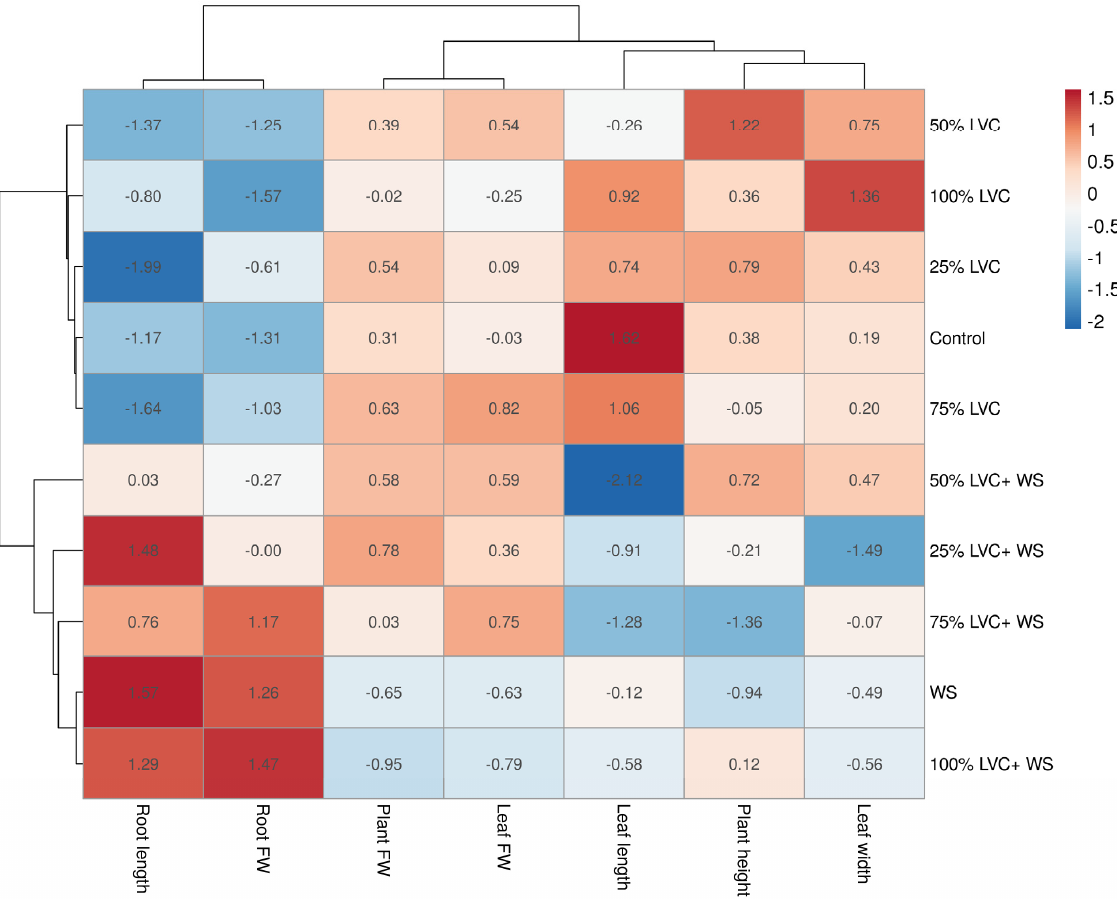
Figure 1. Heat map clustering of agronomic attributes corresponding to the treatments.